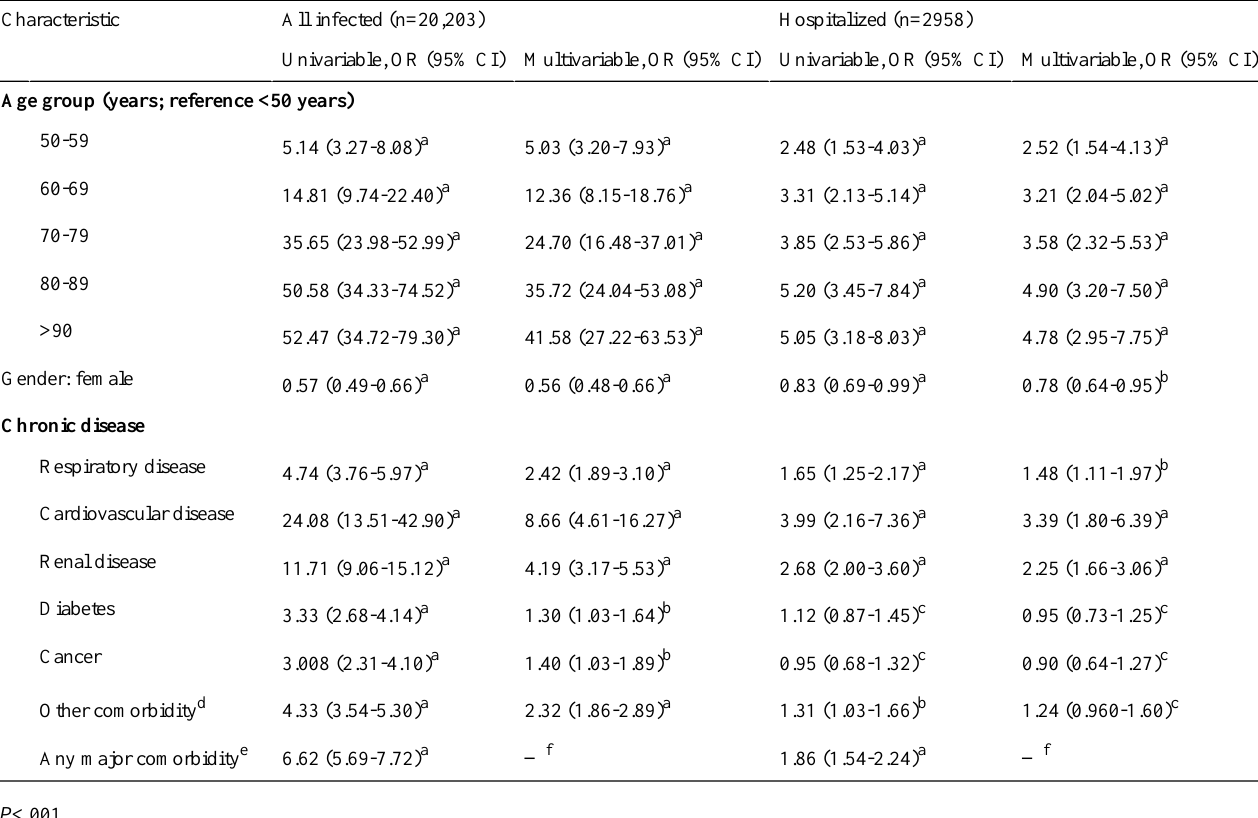
Table 1. Multivariable logistic regression (odds ratios [OR] and 95% CIs) to assess the association between chronic diseases and severe outcomes (death or admission to intensive care unit) following COVID-19